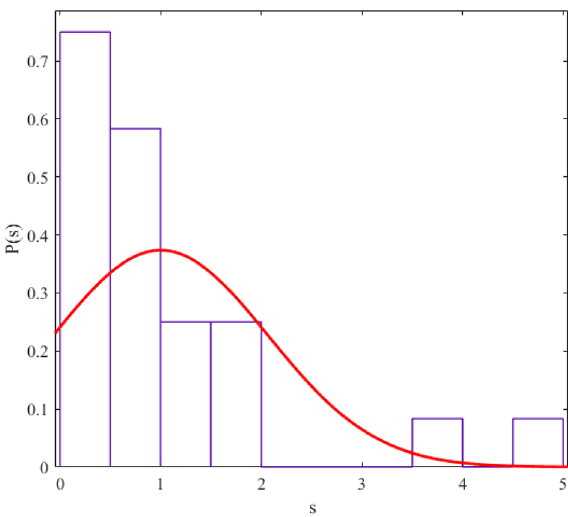
Figure 6. Similar to Fig. 1, the statistical distribution of 4